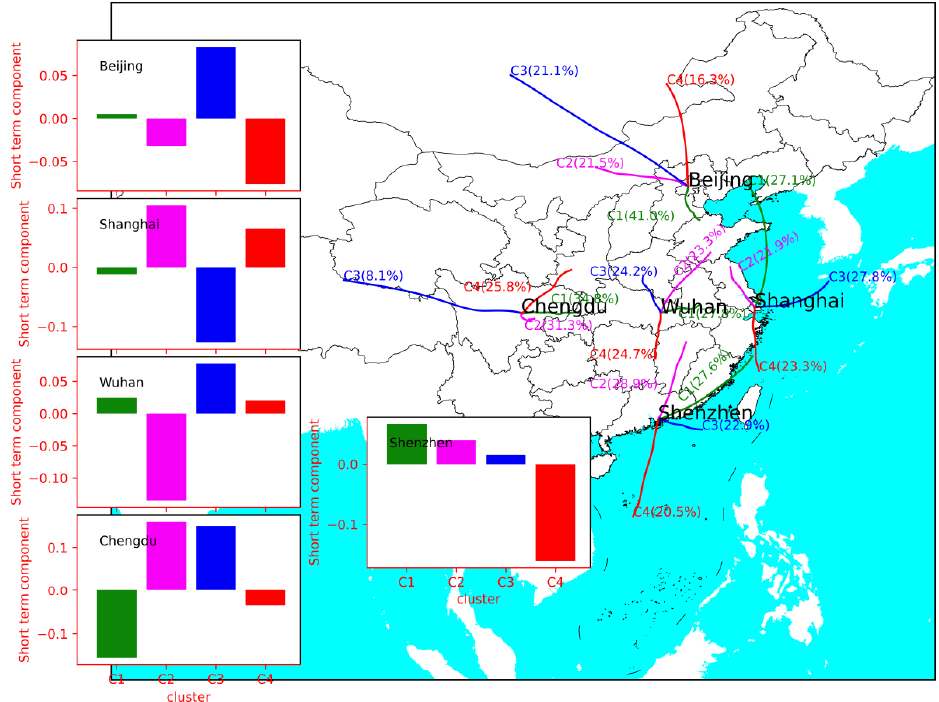
Figure 8. Back trajectory clusters and the mean short-term components of MDA8 O 3 under corre- sponding clusters in Beijing, Shanghai, Wuhan, Chengdu, and Shenzhen.